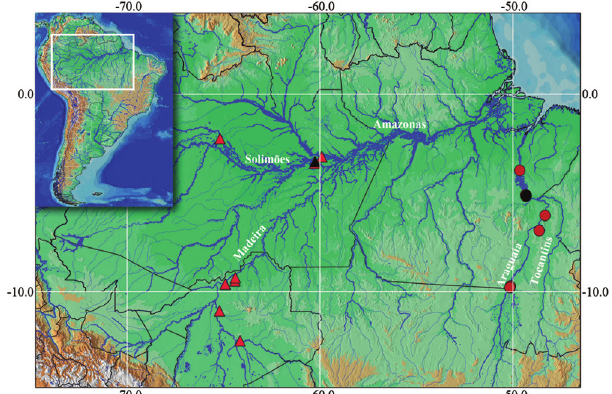
Fig. 2. Lateral view of Hypostomus delimai , NUP 11016, paratype, 176.7 mm SL, from the rio Lontra, rio Araguaia basin, in the border of Pará and Tocantins States, Brazil.